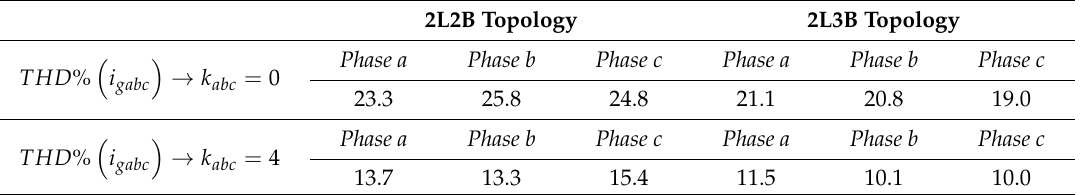
Table 4. Reduction of THD of the i gabc currents with the increase of the k abc gain for both topologies. 2L2B Topology 2L3B Topology Phase a Phase b Phase c Phase a Phase b (cid:16) (cid:17) → k = 0 THD % i gabc abc Phase (cid:16) (cid:17) → k = 4 THD % i gabc abc